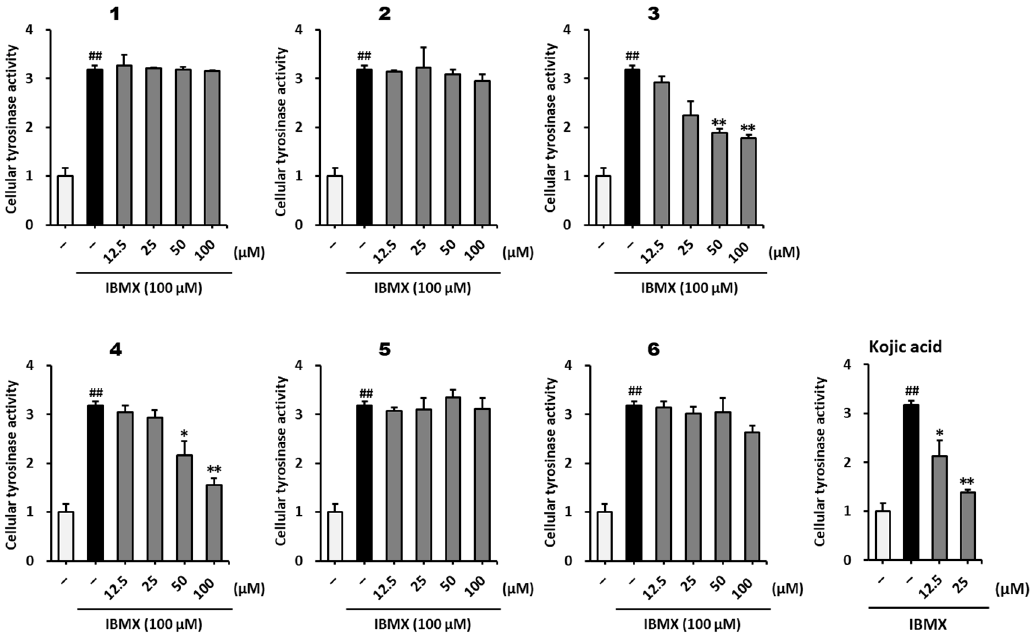
Figure 4. Effect of methoxyflavones 1–6 on cellular tyrosinase activity in B16F10 cells. B16F10 cells were seeded in a 60 mm dish at a density of 5 × 10 5 cells and incubated for 24 h. The cells were then incubated with IBMX and the indicated concentrations of methoxyflavones 1 – 6 for 72 h. Cellular tyrosinase activity was evaluated using L -3,4-dihydroxyphenylalanine ( L -DOPA). Kojic acid was used as a positive control. The results are presented as the mean ± SEM ( n =3). ## p < 0.01 compared with the untreated group. * p < 0.05 and ** p < 0.01 compared to the IBMX-treated group.